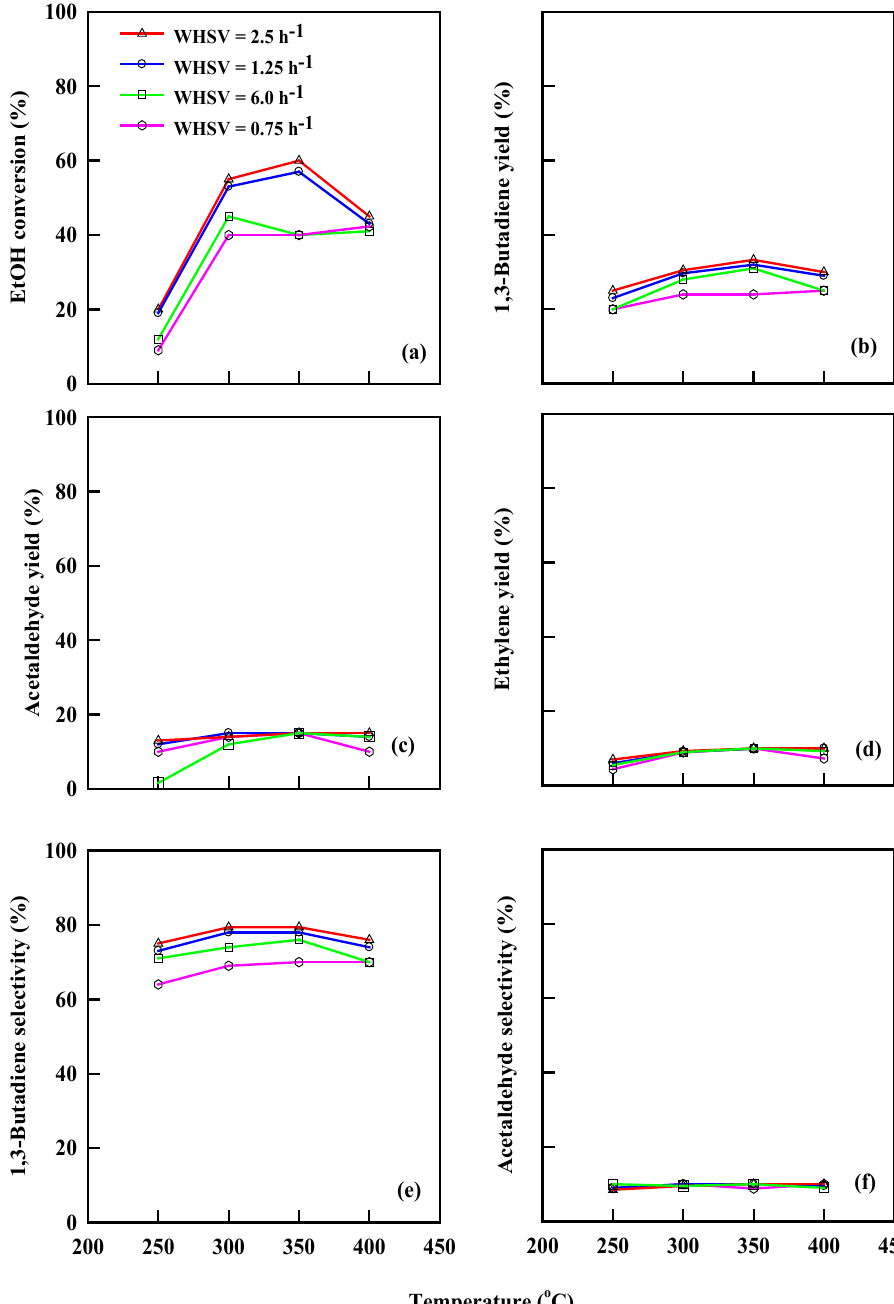
Figure 6 highlights the use of ash in combination with MgO (1:1). This combination achieved an ethanol conversion of 60% at 350 ◦ C and 2.5 h − 1 . At a WHSV of 2.5 h − 1 and 1.25 h − 1 , the ethanol conversion rate was 60% and 57%, respectively. At 6.0 h − 1 and 0.75 h − 1 , the ethanol conversion decreased to 40% at 350 ◦ C. However, ethanol conversion reached a static constant in the range of 45–40% at 400 ◦ C.